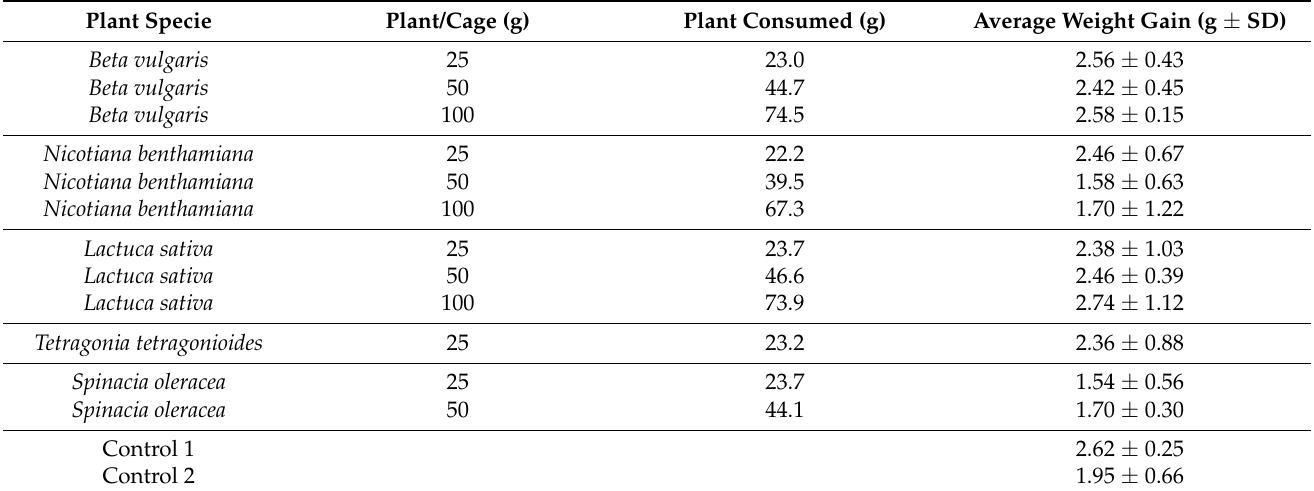
Table 1. Weight gain of BALB/cAnNRj mice after feeding with plant-supplemented diets for 48